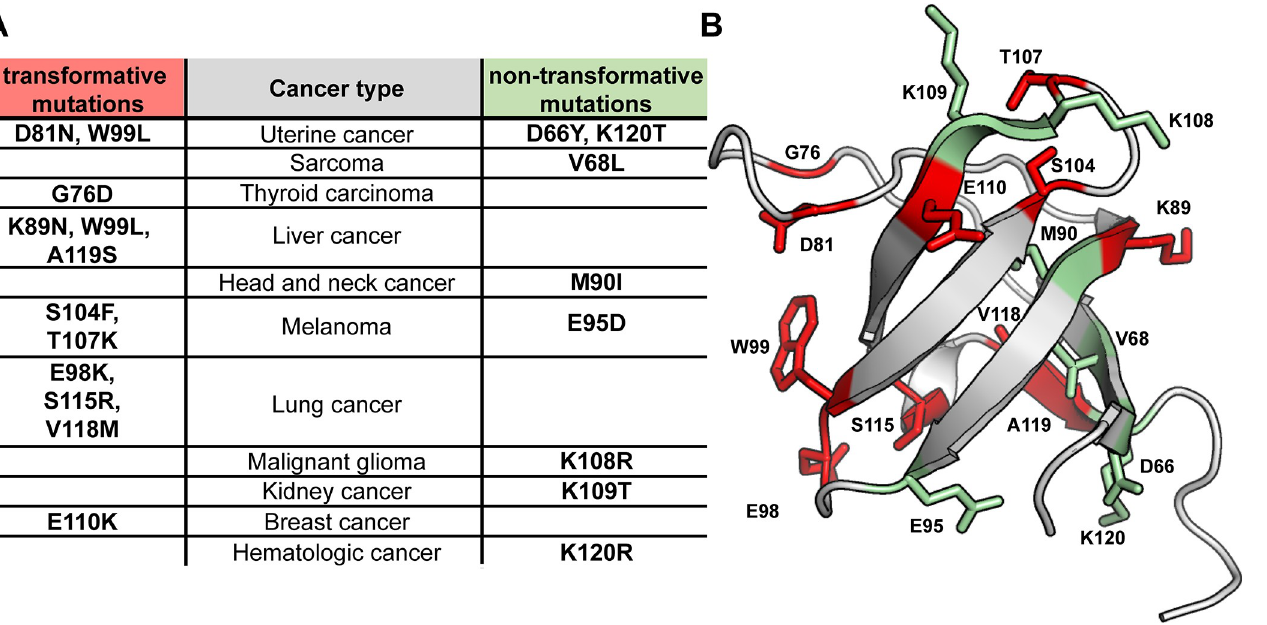
PLOS ONE | https://doi.org/10.1371/journal.pone.0215140 April 10,